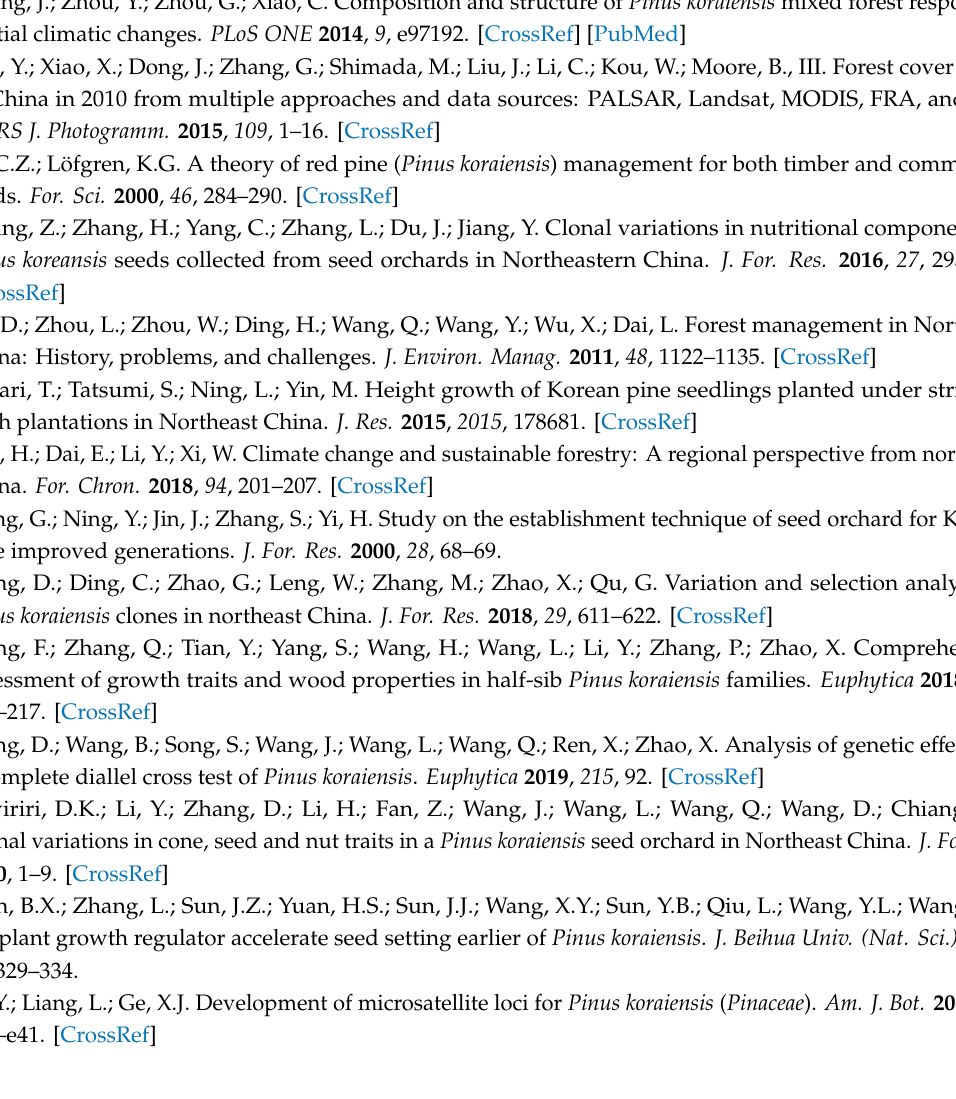
Figure S1: Clustering dendrogram showing cluster patterns of 110 Punis koraiensis clones grown at the Naozhi orchard using the unweighted pair-group average method with Mahalonobis coe ffi cient of disimilarity indices on 28 growth, wood, cone, seed and nut traits., Figure S2: Genetic structural and clusters grouping of 110 Punis koraiensis clones based on SSR data using Structure Selector, Table S1: Primer sequences and polymorphism characteristics of SSR markers used to characterize 110 P. koraiensis clones grown at the Naozhi seed